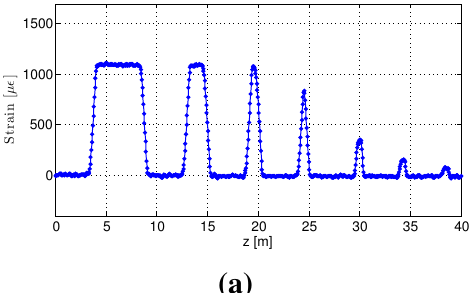
Figure 15. Experimental BOTDR results: ( a ) strain estimates and ( b ) the Brillouin spectrum at the 5-m strain